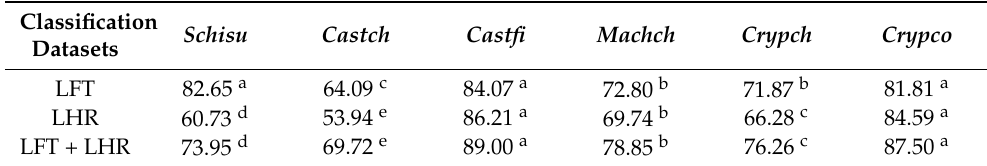
Table 3. The classification accuracies (%) of tree species based on different datasets.